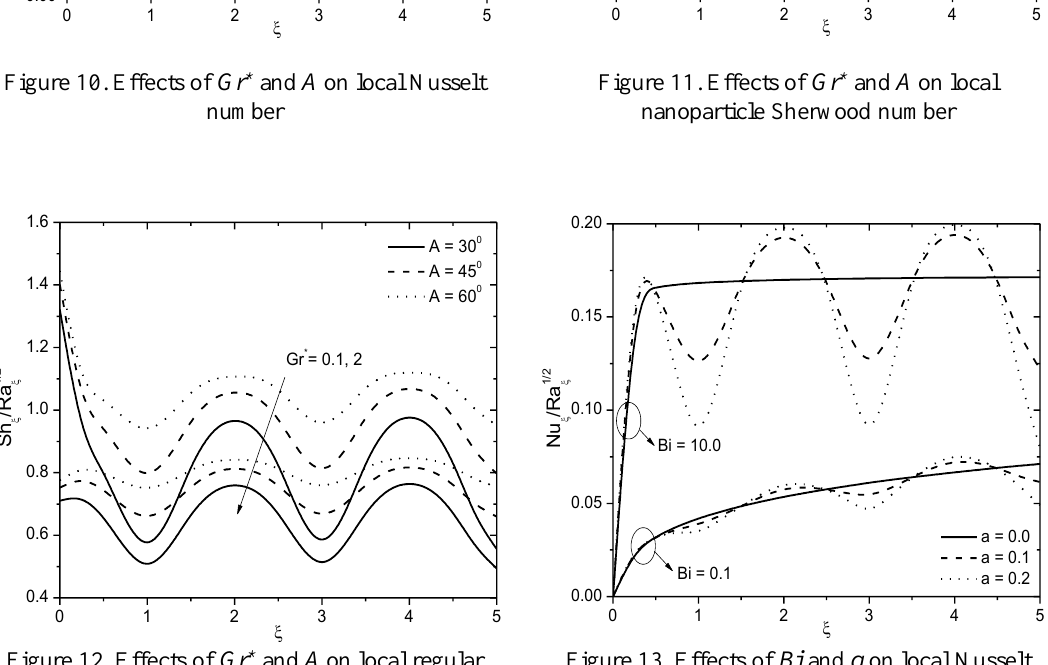
Figure 13. Effects of Bi and a on local Nusselt